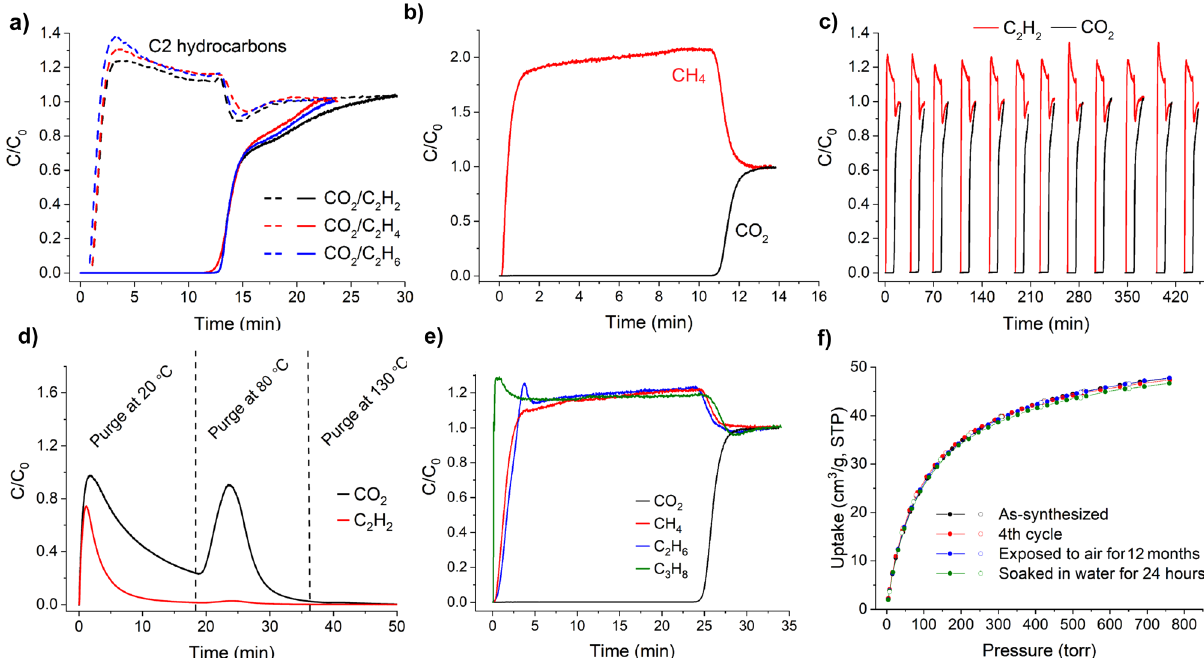
Fig. 6 Gas separation by MUF-16. a Experimental breakthrough curves for 50/50 mixtures of CO 2 and the three C2 hydrocarbons (measured independently) at 293 K and 1.1 bar in an adsorption column packed with MUF-16. b Experimental breakthrough curves for 50/50 mixtures of CO 2 and CH 4 at 293 K and 1.1 bar in an adsorption column packed with MUF-16. c Twelve separation cycles for a CO 2 /C 2 H 2 mixture (50/50 mixture). Each separation process was carried out at 293 K and 1.1 bar. MUF-16 was regenerated between cycles by placing it under vacuum at ambient temperature for 20 – 25 min. d Experimental desorption pro fi le of MUF-16 following the separation of CO 2 and C 2 H 2 upon heating under a helium fl ow of 5 ml N /min at 1.1 bar. No adsorbates were removed upon further heating at 130 °C indicating that they had been fully expelled at lower temperatures. e Experimental breakthrough curves for a 15/80/4/1 CO 2 /CH 4 /C 2 H 6 /C 3 H 8 mixture at 1.1 bar and 293 K in an adsorption column packed with MUF-16. f CO 2 adsorption isotherms (293 K) of as-synthesized MUF-16 after four consecutive adsorption-desorption cycles, after exposing it to air with ~80% humidity for 12 months, and after immersion in water for 48 hours. Source data are provided as a Source Data fi